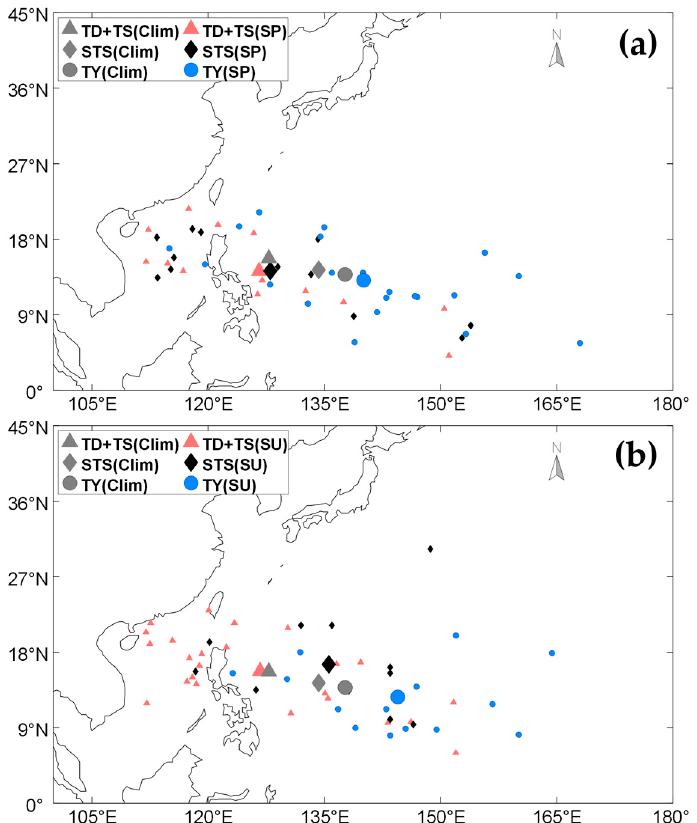
Figure 3. The genesis positions of the different classifications of landfalling TCs in China during SP ( a ) and SU ( b ) El Niño years. The different symbols denote the genesis positions of TD+TS (triangle), STS (diamond), and TY (dots). The gray symbols indicate the mean TC genesis positions between 1951 and 2017 with regard to the TC categories.